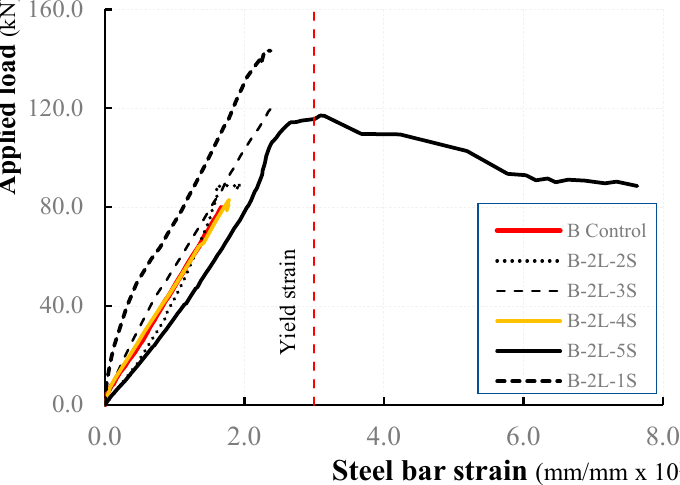
Figure 14. Load–steel bar strain curves for beams strengthened with two-layer SRG strips.